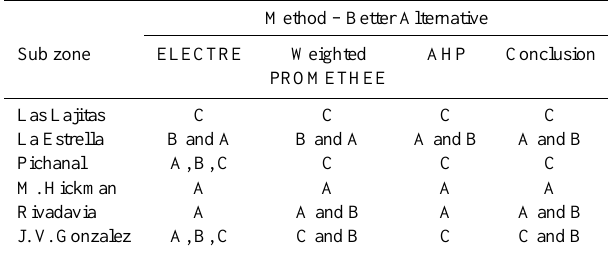
Table 5. Summary of MCDM application to alternatives to deserti- fication and erosion control in Salta province